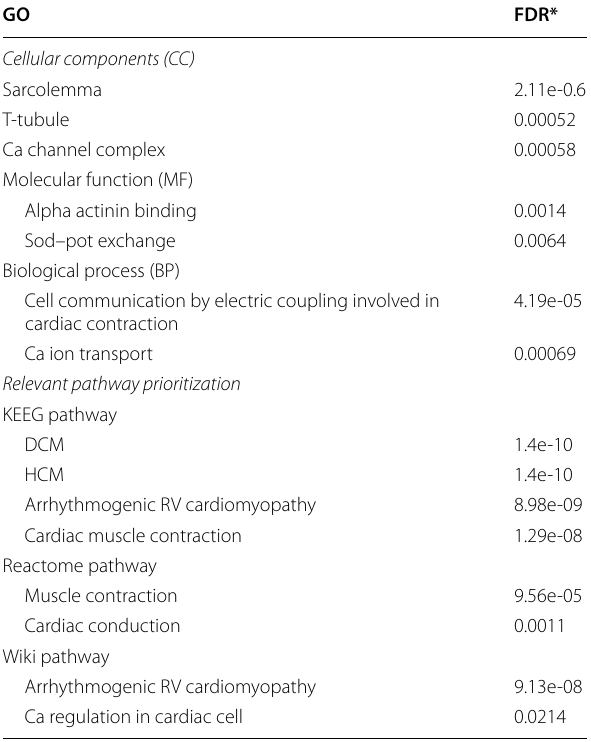
Table 5 GO analysis for whole targeted genes ( n 194‑5p and miR‑454‑3p using STRING